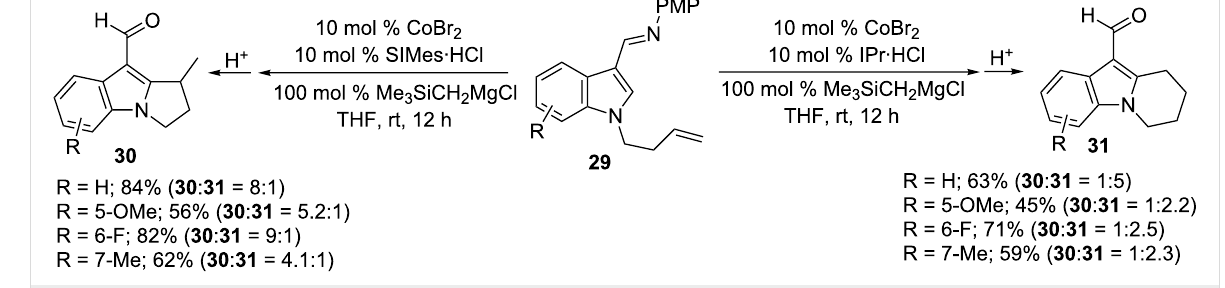
Scheme 22: Co-catalyzed intramolecular hydroarylation of indoles.